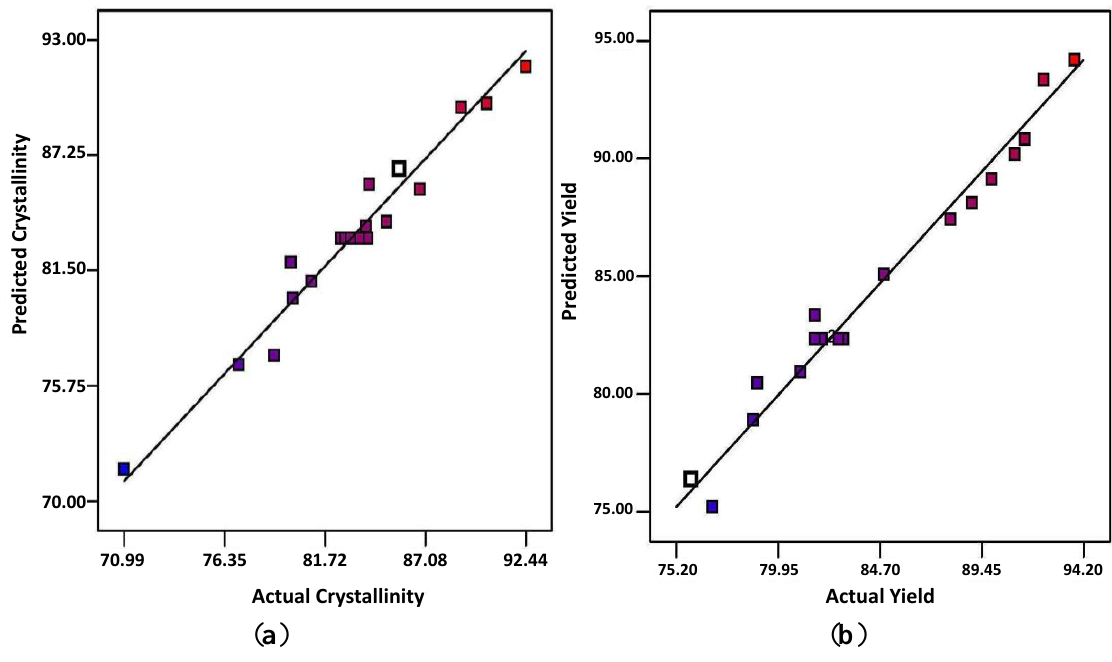
Figure 1. Predicted versus actual: ( a ) percentage of crystallinity; ( b ) yield of acid hydrolyzed microcrystalline cellulose (MCC).